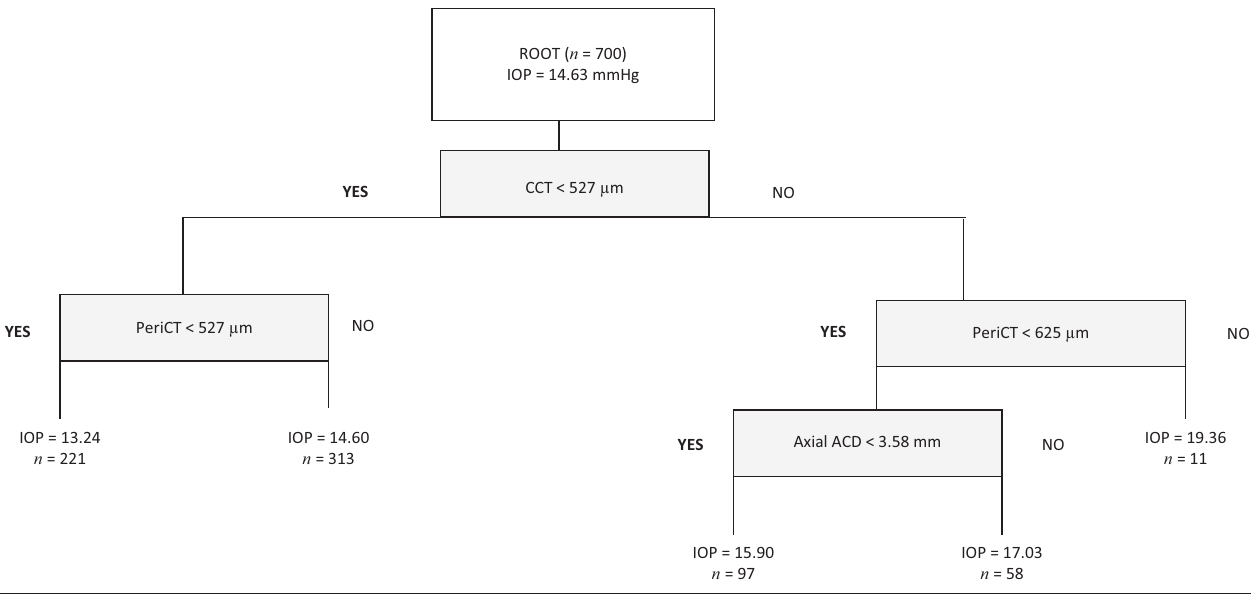
FIGURE 4: Pruned regression tree model, automatically generated by the classification and regression tree method, for prediction of intraocular pressure.